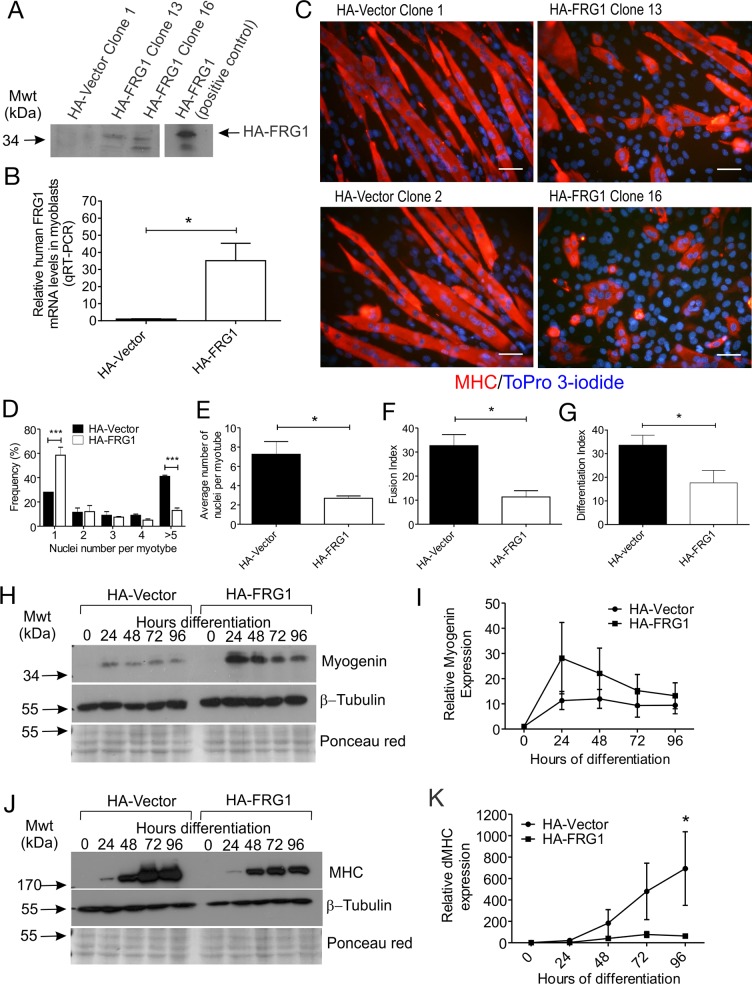
C2C12 myoblasts overexpressing FRG1 exhibit a fusion defect.(A) Immunoblot analysis of FRG1 expression in C2C12 myoblasts expressing HA-vector or HA-FRG1. HA-tagged FRG1 was detected using a HA-specific antibody. Clones HA-FRG1 13 and HA-FRG1 16 were selected for further analysis. Positive control represents HA-FRG1 transfected COS1 cells. (B) qRT-PCR analysis of FRG1 mRNA levels in undifferentiated HA-FRG1 myoblasts relative to HA-vector control myoblasts. Data represent the mean +/- SEM from n = 3 independent experiments; *p<0.05. (C) Representative images of C2C12 myoblasts expressing either HA-vector control or HA-FRG1 as indicated, following 96 hours differentiation and stained with the differentiation marker MHC (red) and ToPro 3-iodide to detect nuclei (blue). (D-F) Several parameters were quantified to assess the efficiency of myoblast differentiation; (D) Frequency of MHC-positive myoblasts and myotubes containing 1, 2, 3, 4 or ≥5 nuclei. Data represent the mean ± SEM from n = 3 independent experiments;***p<0.0005 determined by two-way ANOVA with Tukey’s multiple comparisons test; (E) Average number of nuclei per myotube; (F) Fusion index; the percentage of total nuclei localized within MHC-positive myotubes; (G) Differentiation index; the percentage of total nuclei localized within MHC-positive cells (myocytes and myotubes); (H-I) Relative myogenin and (J-K) MHC expression in HA-vector versus HA-FRG1 expressing myoblasts during 0–96 hours differentiation. Immunoblotting for β-tubulin and staining membranes with ponceau red were used as a loading control. Myogenin and MHC expression were quantified using densitometry. Data for (B), (E-F), (I) and (K) represent the mean ± SEM from n = 3 independent experiments; *p< 0.05 determined by two-tailed Student’s T-test. Scale bars = 50μm.